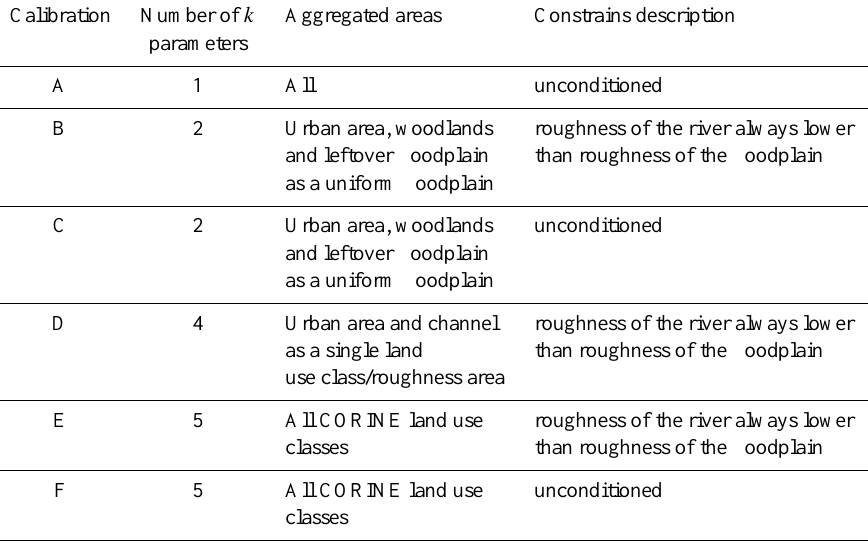
Table 1. Different calibration strategies and parameter aggregation used in the study ( k = Strickler roughness coefficients).